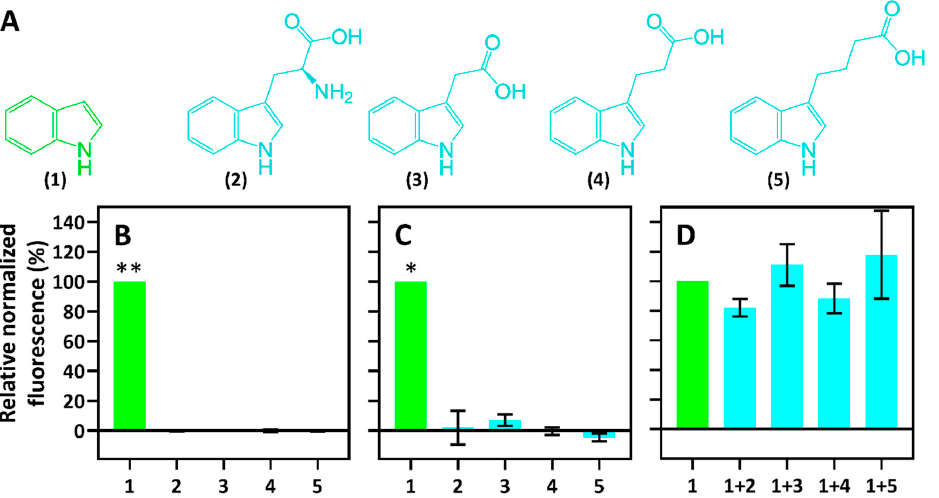
Figure 4. Specificity of Pp TrpI/P PP_RS00425 -based whole-cell biosensors. ( A ) Compounds that were